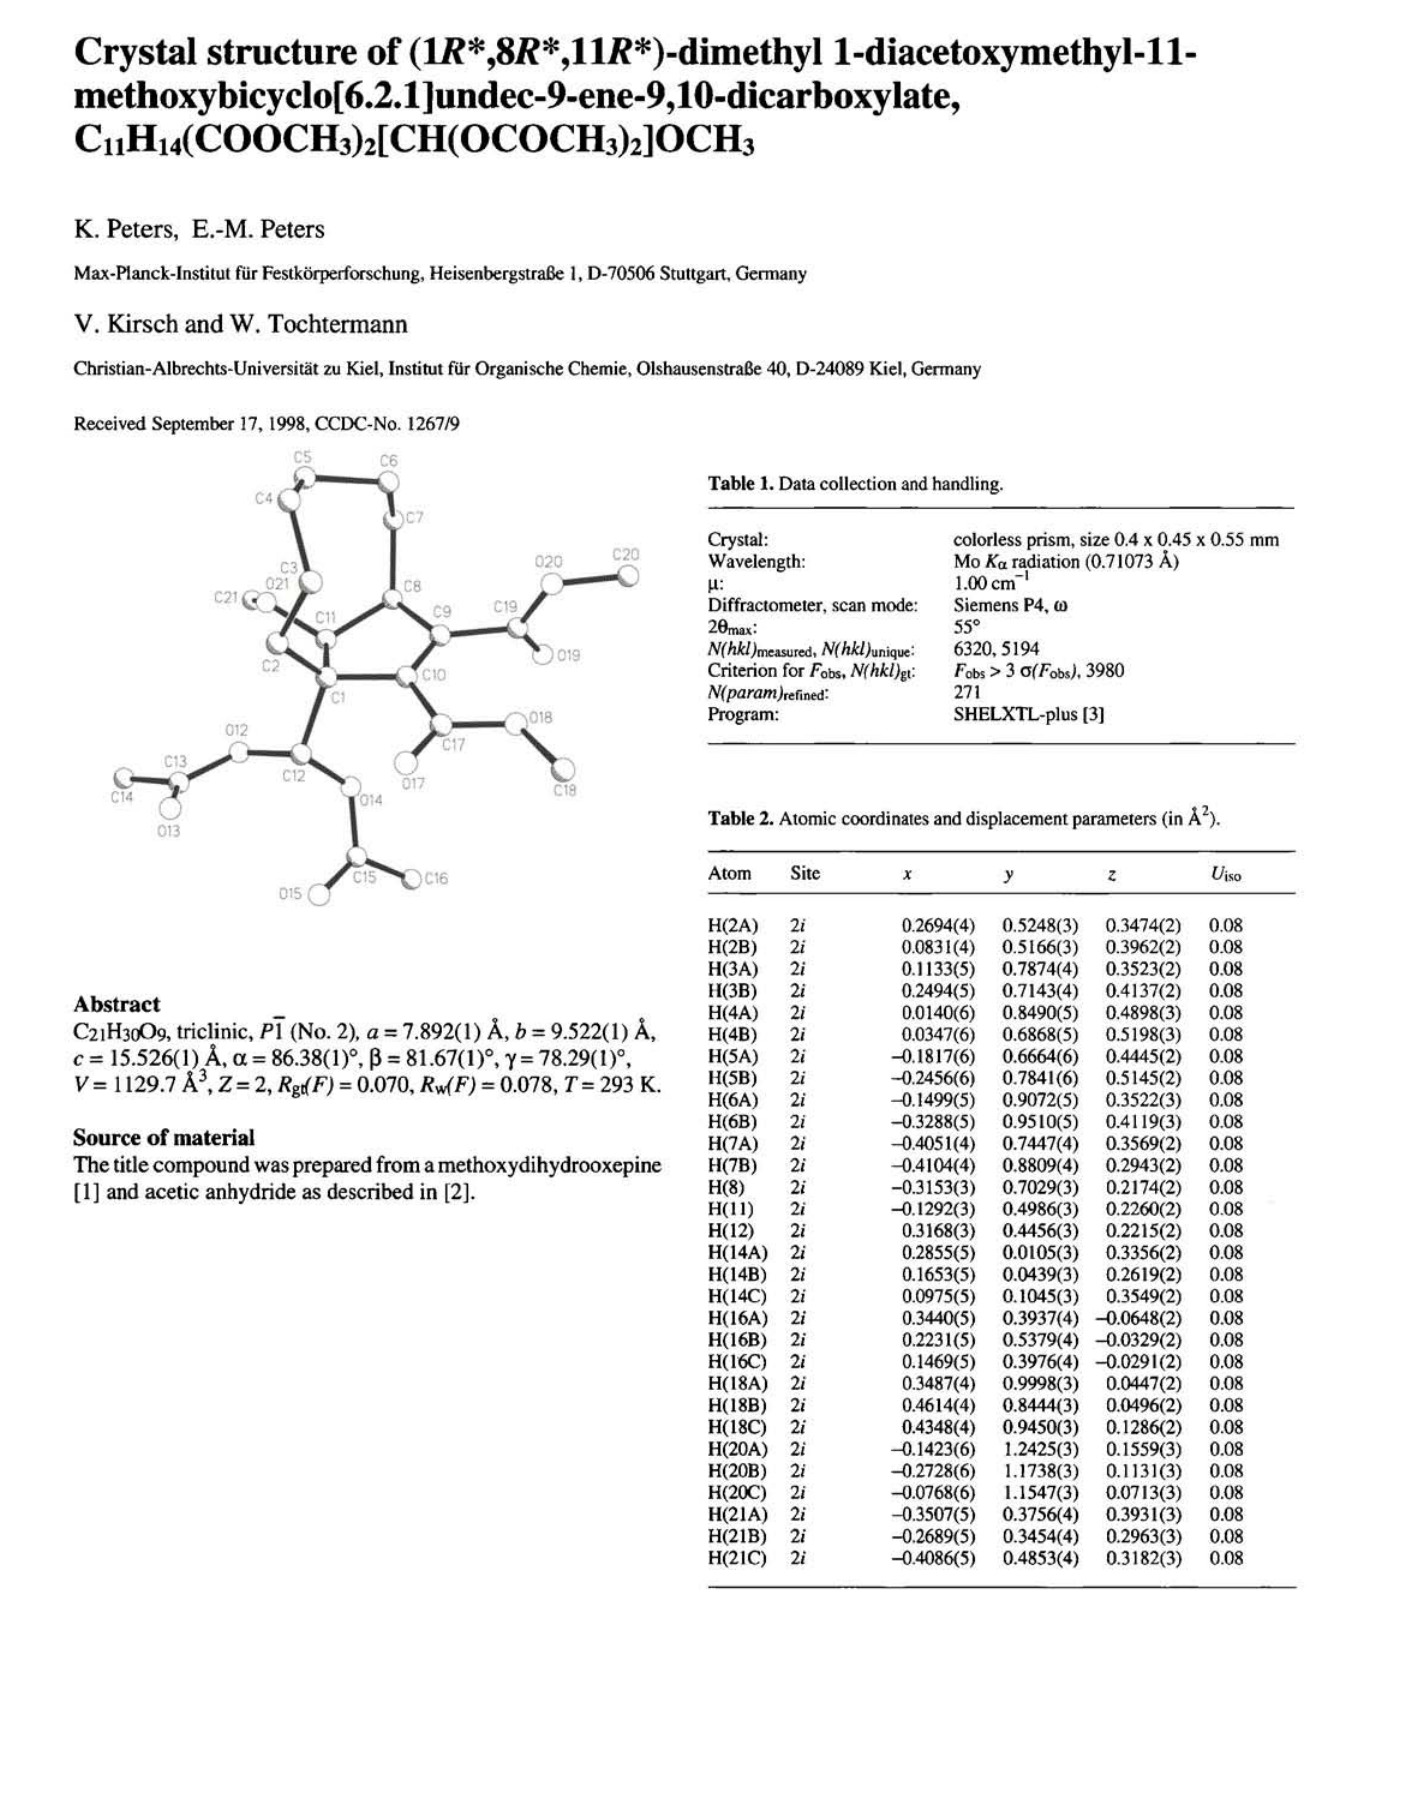
Table 2. Atomic coordinates and displacement parameters (in Â 2